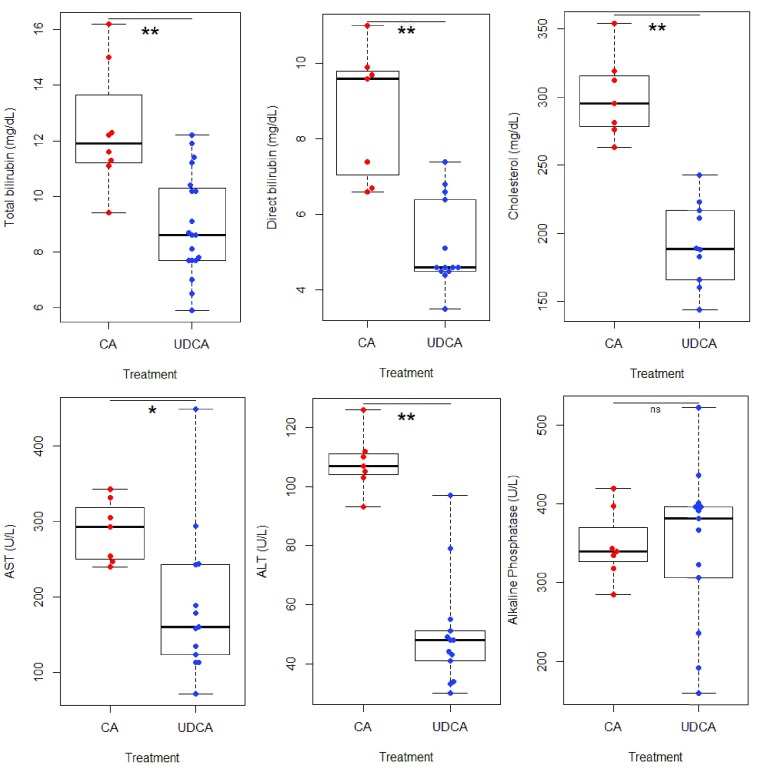
Boxplots of hepatic function parameters from Case 1.These indicate statistically significant (Student’s T-test, performed with Rv3.2.0: *, p < 0.05; **, p < 0.005) elevations in all denoted parameters except alkaline phosphatase, while on cholic acid (CA) compared to ursodeoxycholic acid (UDCA) therapy.